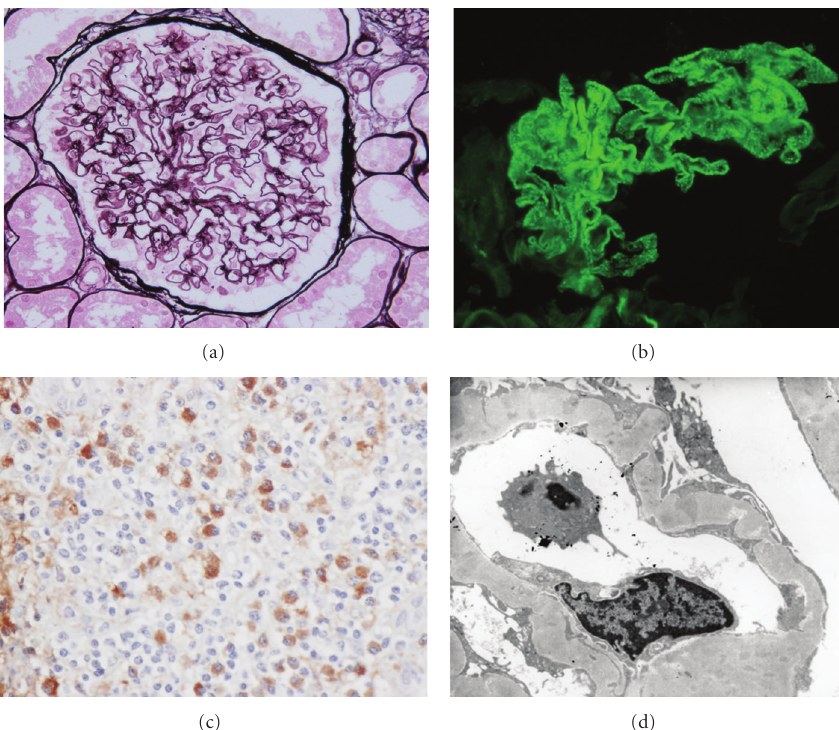
Figure 1: IgG4-related tubulointerstitial nephritis with membranous glomerulonephritis. (a) Periodic acid methenamine silver (PAM) staining reveals spike and bubbling formation (PAM × 400). (b) Immunofluorescence staining for IgG reveals granular deposits along the glomerular capillary walls ( × 400). (c) Many IgG4+ plasma cells are seen in the interstitium (IgG4 × 400). (d) Electron microscopy (EM) shows subepithelial deposits and variable reabsorption of these deposits with thickened glomerular basement membrane. (Ehrenreich-Churg stage